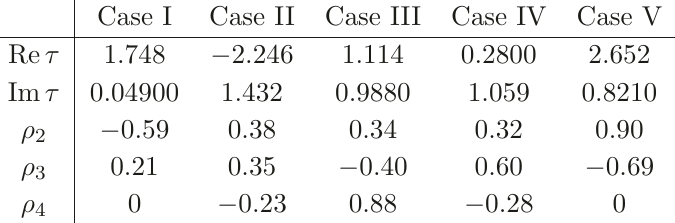
Table 4 . Input parameters ( τ, ρ 2 , ρ 3 , ρ 4 ) for generating the configurations in table 3. Note that ρ 4 is ineffective in Case I and Case V and then we set zero for ρ 4 in these cases.